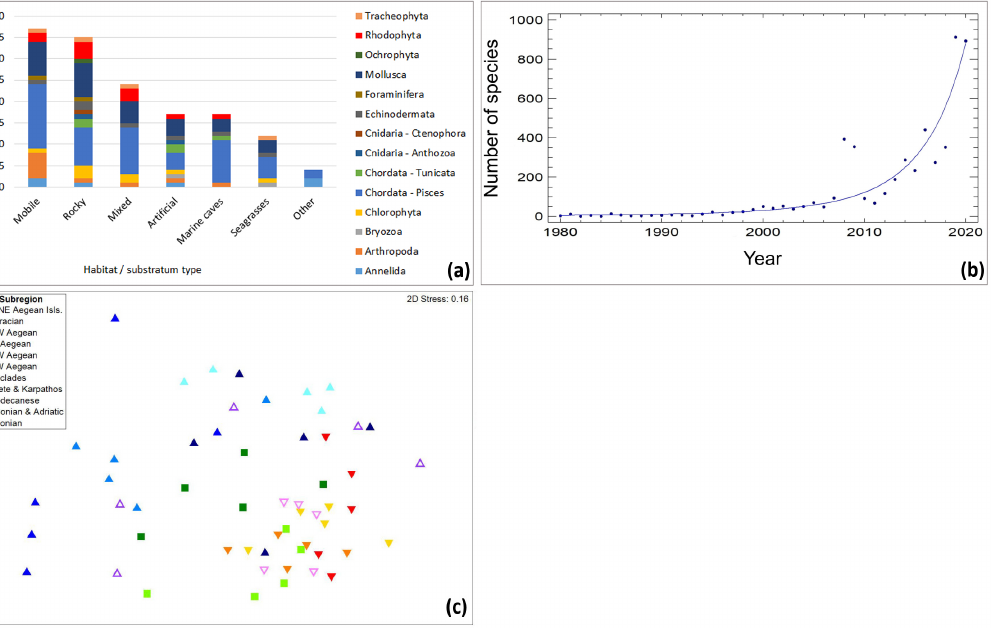
Figure 6. Charts depicting the number of ICAS per habitat or substratum type ( a ) and the numbers and trend of ICAS recorded per year ( b ) and the n-MDS plot presenting the spatial patterns in the ICAS community composition across sites in the 11 subregions of the study area ( c ).